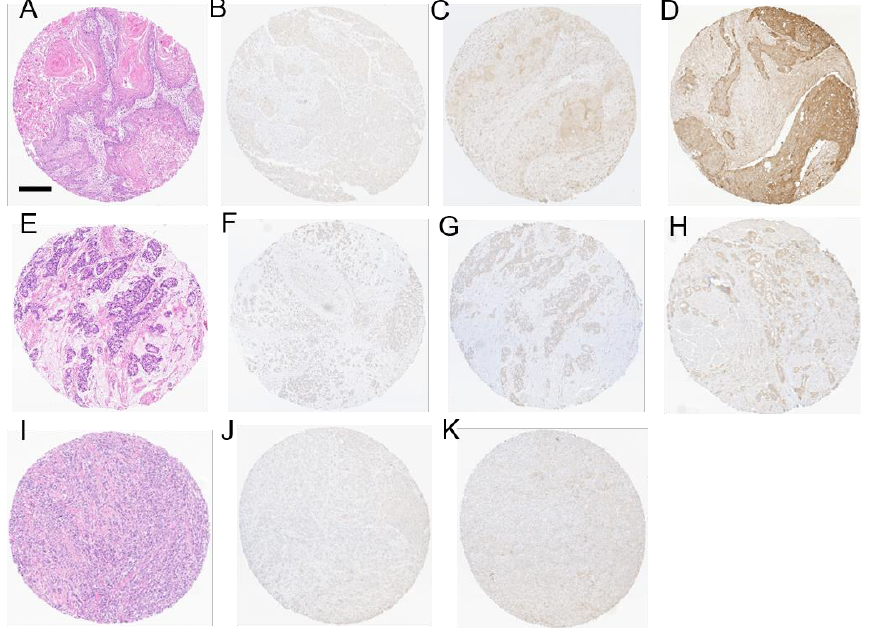
Figure 1. Variant histologies of bladder cancer and Nectin-4 expression levels. ( A – D ) show repre- sentative photomicrographs of tissue microarray (TMA) samples with SCC ( A , H&E) and weak ( B ), intermediate ( C ), and high Nectin-4 expression ( D ). ( E – H ) depict representative photomicrographs of TMA samples with ADENO ( E , H&E) and weak ( F ), intermediate ( G ), and high Nectin-4 expression ( H ). ( I – K ) show representative photomicrographs of TMA samples with SARCO ( I , H&E) and weak ( J ) and intermediate ( K ) Nectin-4 expression. In SARCO, there was no high Nectin-4 expression detected. H&E, hematoxylin – eosin; SCC, pure squamous cell carcinoma of the bladder; ADENO, adenocarcinoma of the bladder; SARCO, sarcomatoid urothelial carcinoma of the bladder; scale bar 200 µm.